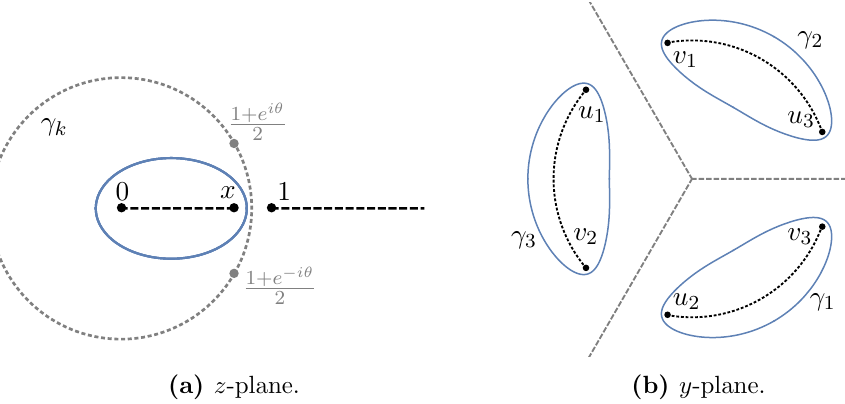
Figure 2. Branch points and cuts, and cycles (cid:13) k in the z and y planes. Dashed lines are branch cuts on the z plane, and dotted lines branch cuts on the y plane. The blue loops are the cycles (cid:13) k around which we (cid:12)x the monodromy. The two sheets of the y plane correspond to the inside and outside of the dotted circle in the z plane, with the points z = 1 and the three sheets of the z plane correspond to the three wedges of the y plane separated by the dashed